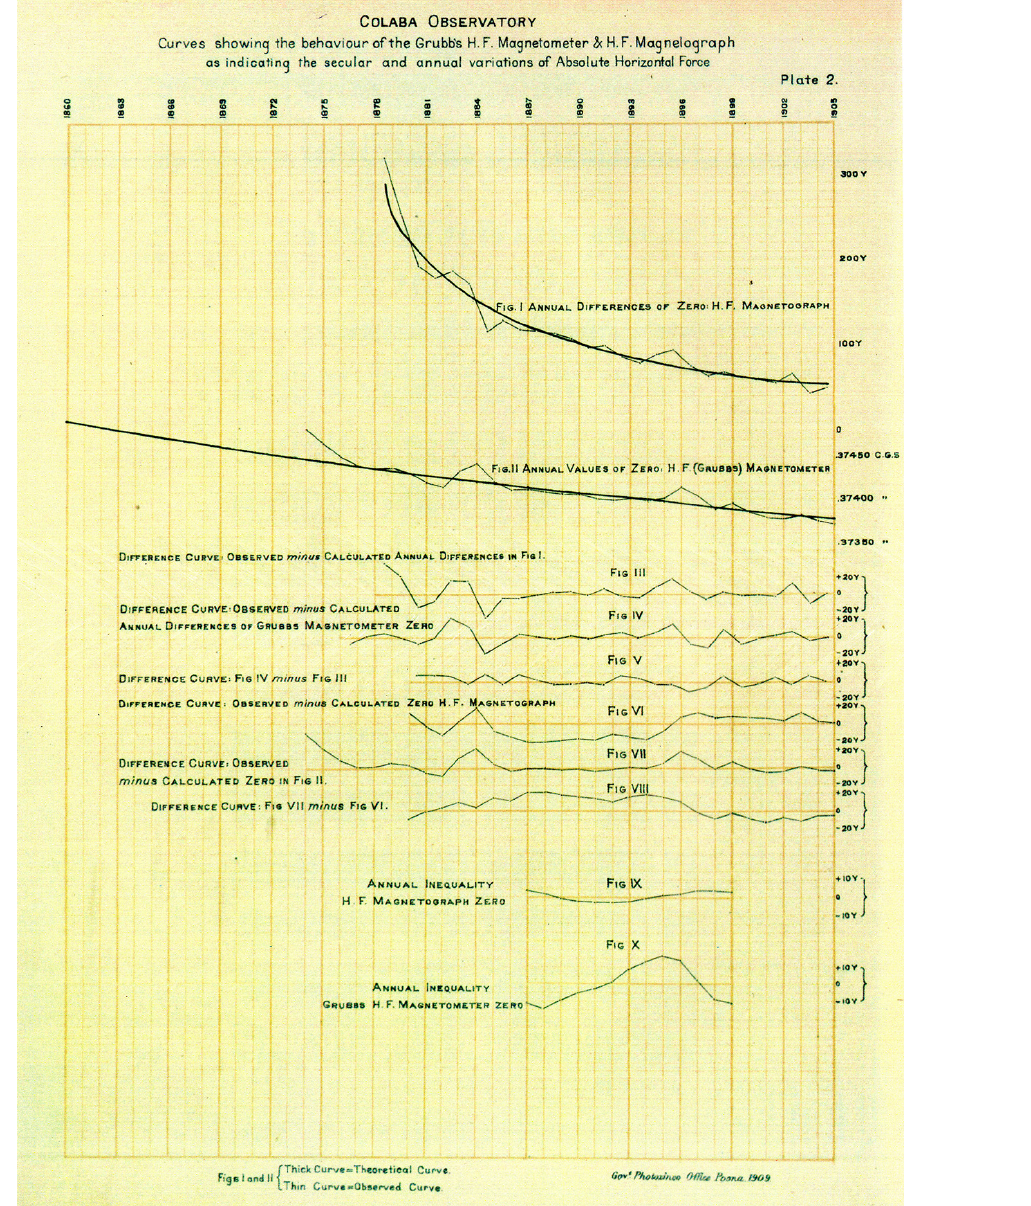
Figure 10. Photograph showing secular and annual variations of absolute horizontal force (Moos,